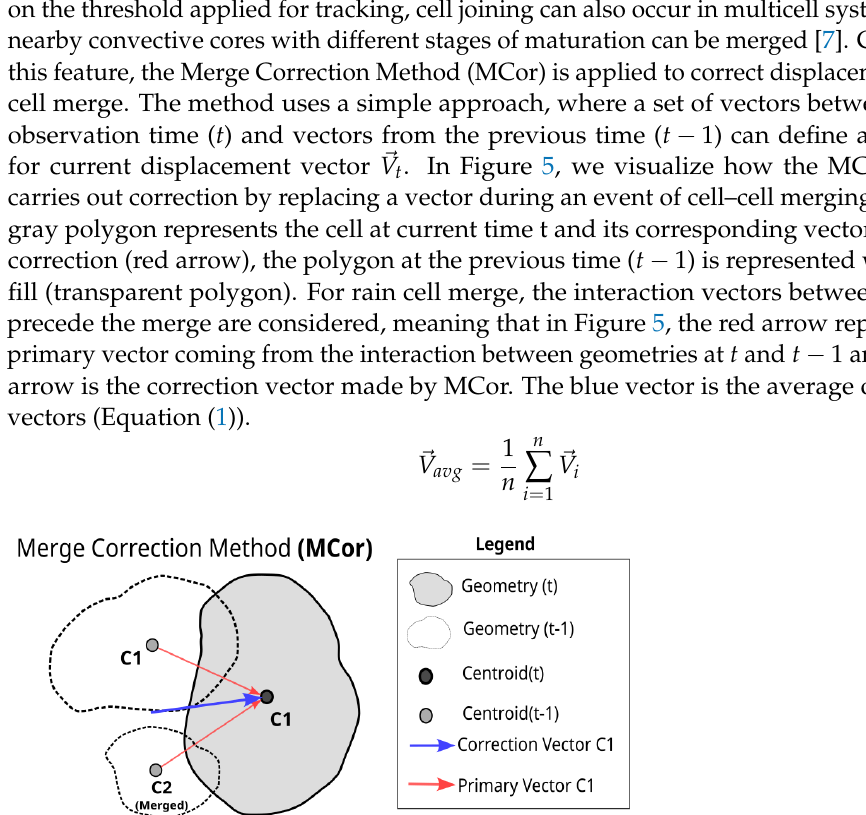
Figure 5. Merge Correction Method scheme. The arrows indicate the displacement vectors associated with the method, where red arrows are the vectors used for the adjustment and the blue arrow is the displacement vector adjusted by the